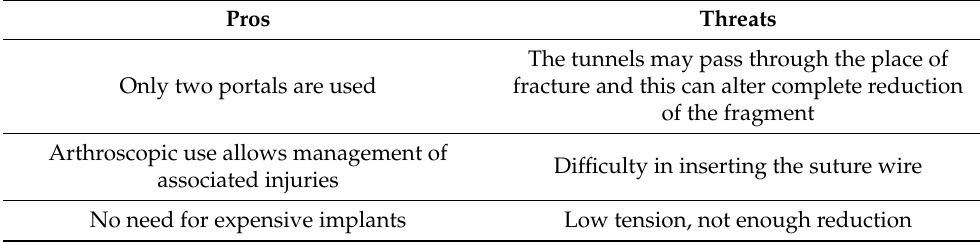
Table 1. Pros and cons of arthroscopic wire suture technique.